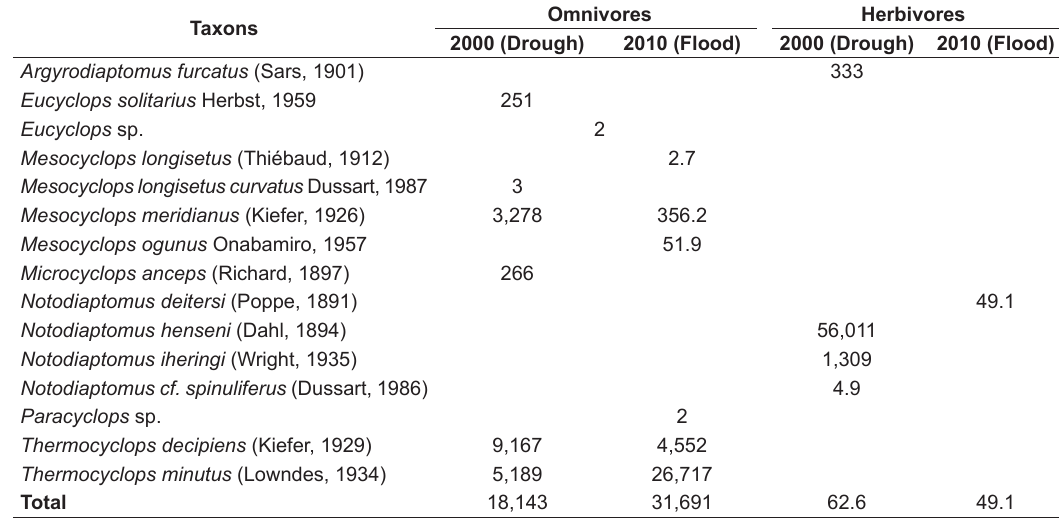
Table 3. List of copepod taxa and abundance (ind m -3 ) registered during the years and study periods in the floodplain of the upper Paraná